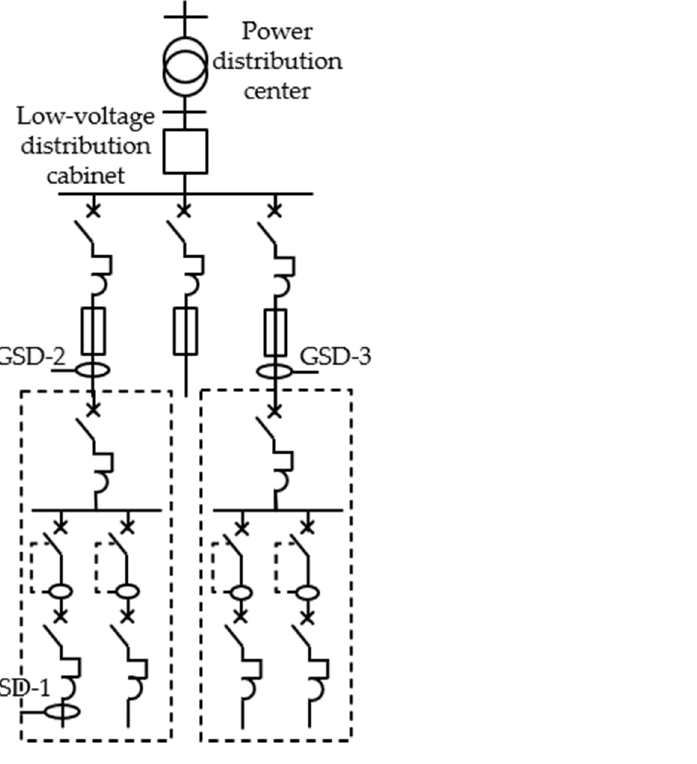
Figure 11. Diagram of the installation of the GPS synchronized data logger (GSD-1, GSD-2, and GSD-3) in different locations of the grid.